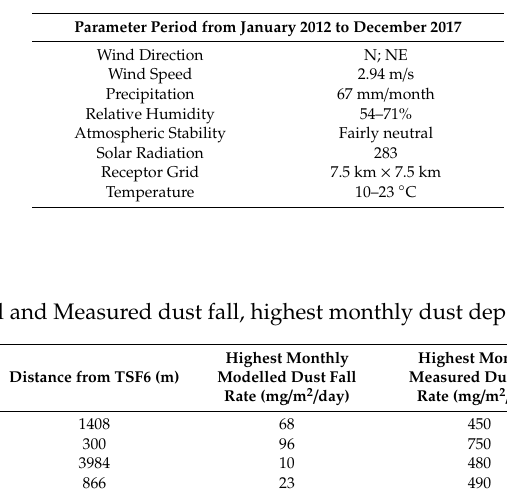
Figure A1. Tailings Storage Facilities sites. Table A1. Meteorological parameters from the WW Mponeng Plant Station. Table A1. Meteorological parameters from the WW Mponeng Plant Station.